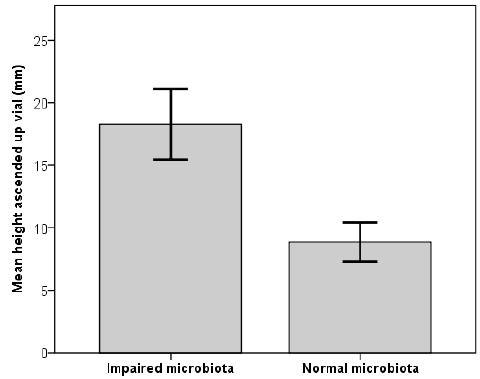
Figure 3. Mean height males climbed up a vial after being knocked to the base, using the Rapid Iterative Negative Geotaxis (RING) test, with either their microbiota impaired (Strep + ) or intact (Strep-). Error bars show 95% confidence intervals.